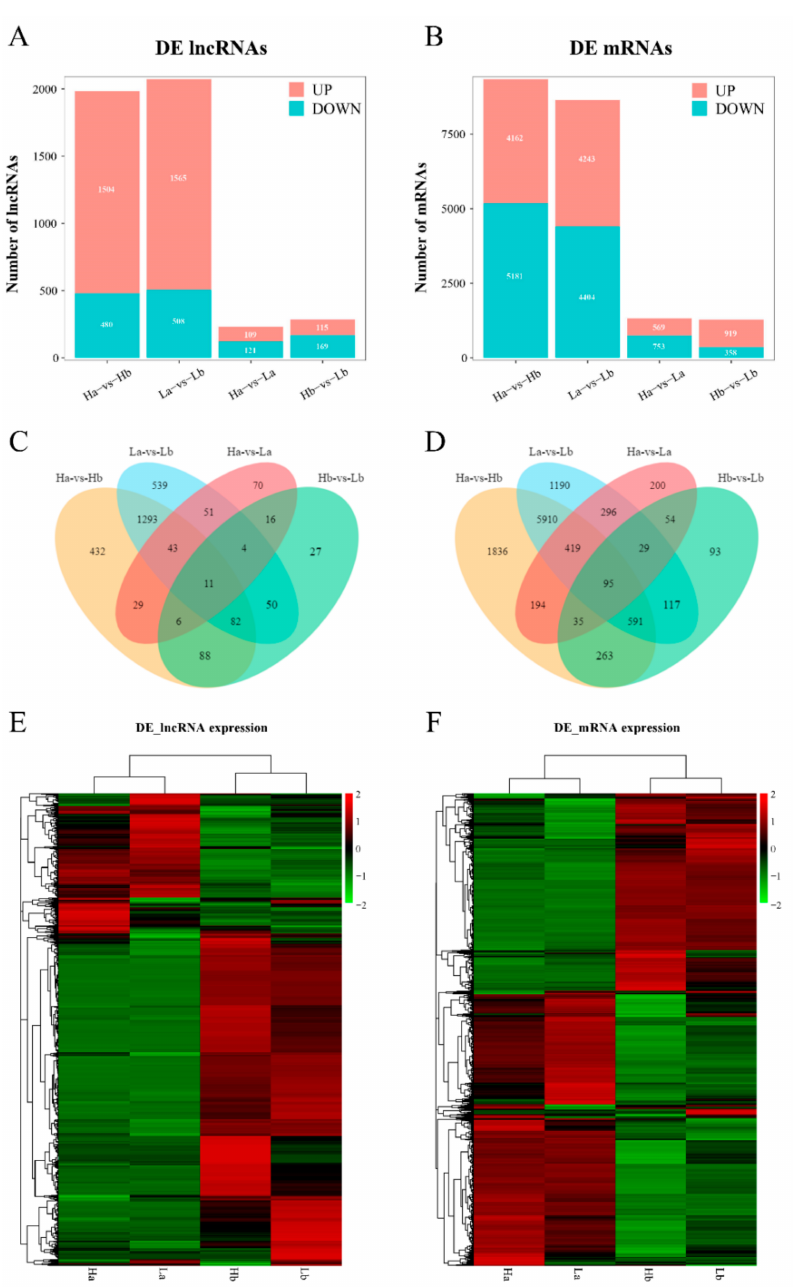
Figure 4. Gene expression number and profiling analyses of differentially expressed lncRNAs and mRNAs among Ha, Hb, La, and Lb groups: Statistics of differentially expressed lncRNAs ( A ) and mRNAs ( B ) among groups; Venn diagram of differentially expressed lncRNAs ( C ) and mRNAs ( D ) in four comparison groups; cluster analyses of differentially expressed lncRNAs ( E ) and mRNAs ( F ) of 12 pig testes by hierarchical heat map. Data are expressed as FPKM. Red and green represent higher expression levels and lower expression levels,